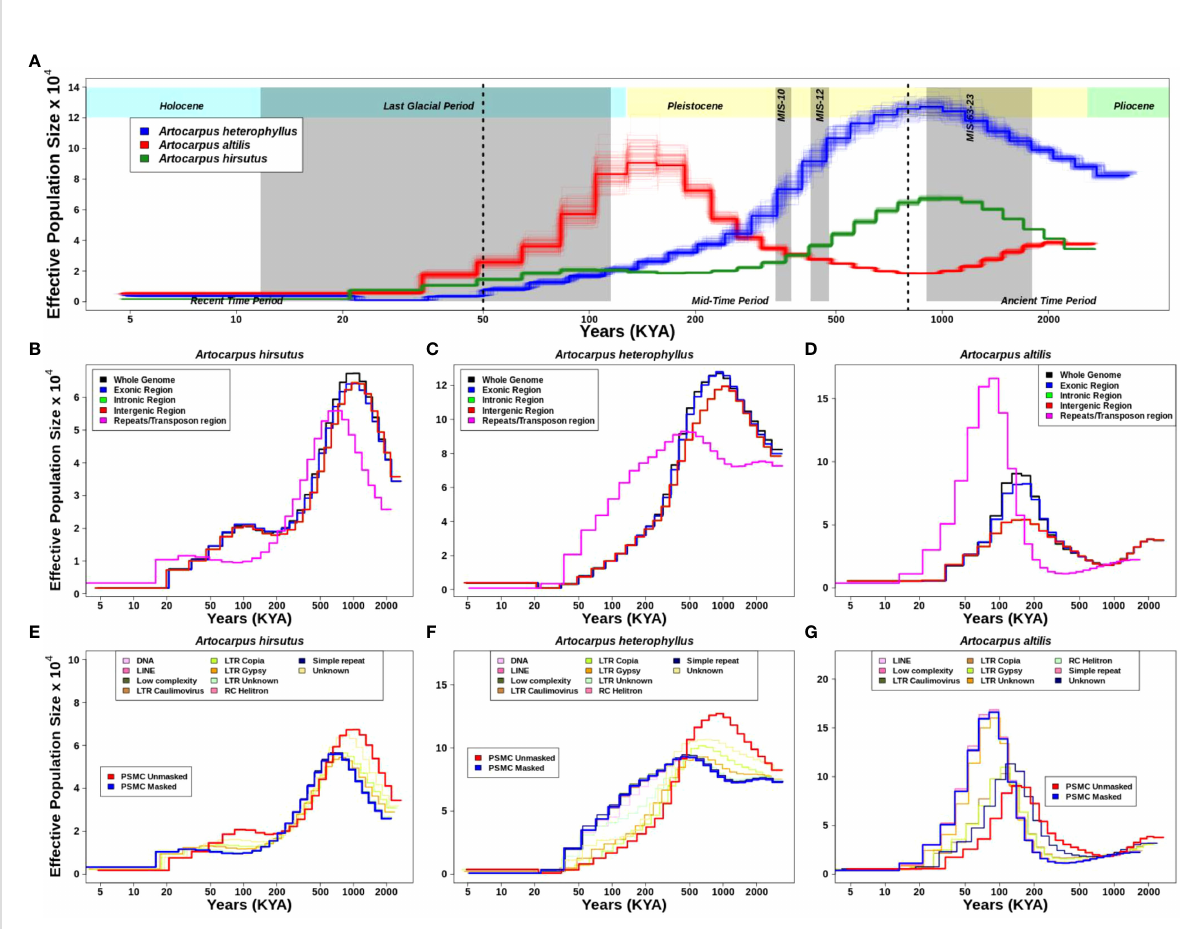
FIGURE 4 Demographic history reconstruction of three Artocarpus species. (A) . Demographic history of A. heterophyllus (blue), A. altilis (red), and A. hirsutus (green) are represented by the respective trajectories with additional bootstrapped lines. The two dotted vertical lines are used to demarcate the recent, mid and ancient time periods following the timeline shown. The grey vertical shading represents the corresponding glacial event. Demographic trajectories and the effect of genome fraction used for PSMC inference in (B) . A. hirsutus , (C) . A. heterophyllus , and (D) . A. altilis . The effect of different repeat types on PSMC inference is represented in (E) . A. hirsutus , (F) . A. heterophyllus , and (G) . A. altilis . The amount of change due to LTR-Copia is most prominent in A. heterophyllus